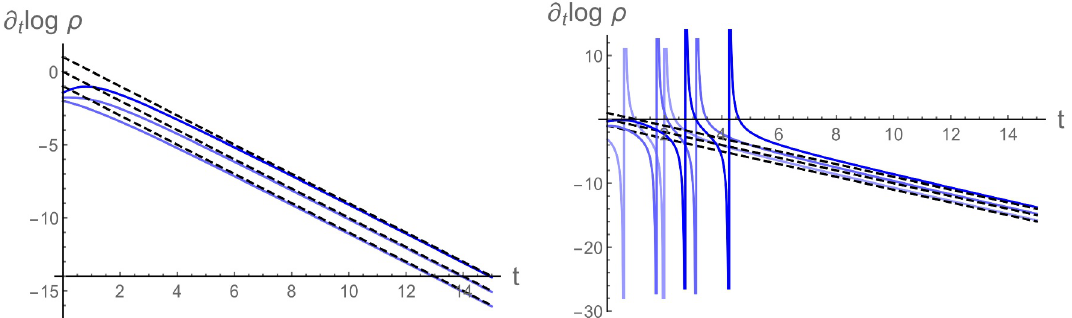
Figure 8 . Left: ∂ t log ρ for s = 1 and P ( k ) = 1 . Solid blue lines correspond to the numerical integration of the exact expression, dashed black lines to the late-time behavior prediction (4.5). From bottom to top, x = 0 , 1 and 2 . Right: same as left, now with P ( k ) given by a even, fourth- order polynomial in k with generated once and for all random